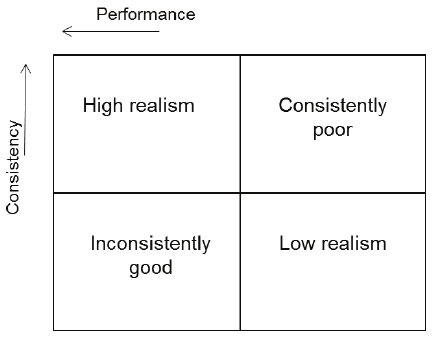
Fig. 2. Consequences for model structures for different combina- Fig. 2: Consequences for model structures for different com- tions of performance and consistency, under the condition that the binations of performance and consistency, under the condi- uncertainty of the input data is limited. The use of signatures for the evaluation of performance and consistency limits the influence of tion that the uncertainty of the input data is limited. The use input of signatures for the evaluation of performance and consis- tency limits the influence of input uncertainty.